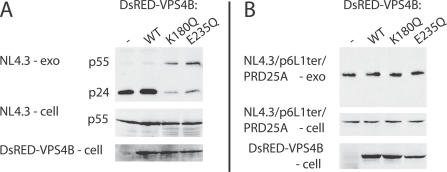
Removal of p6 Allows HIV to Bud Independently of Class E VPS FunctionJurkat T cells were co-transfected the HIV proviruses (A) pNL4.3ΔEnv::GFPkdel or (B) pNL4.3ΔEnv::GFPkdel/p6L1ter/PRD25A, and plasmids designed to express (left lanes) no VPS4B protein (−), (center left lanes) DsRED-VPS4B (WT), (center right lanes) DsRED-VPS4B/K180Q (K180Q), or (right lanes) DsRED-VPS4B/E235Q (E235Q). Two days later, the cells and exosomes were collected, separated by SDS-PAGE (constant ratio of cells:exosomes in all experiments), and processed for immunoblot using antibodies specific for (upper and middle panels) HIV Gag and (lower panel) DsRED.